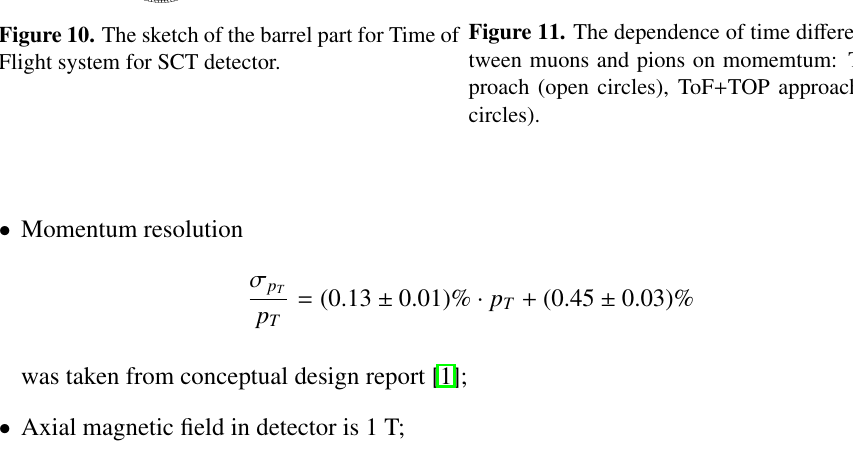
Figure 10. The sketch of the barrel part for Time of Flight system for SCT detector.